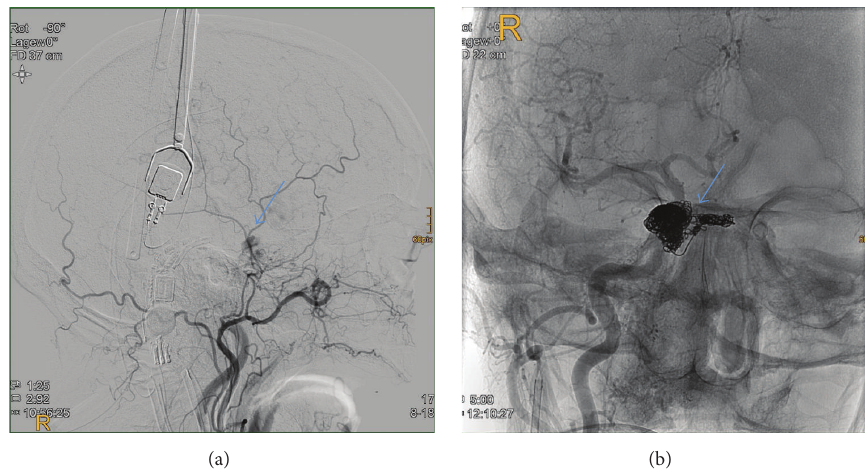
Figure 2: (a) DSA sagittal image. Contrast agent leaking into the right cavernous sinus. (b) The right sphenoid sinus after coil-embolization through right transfemoral transvenous